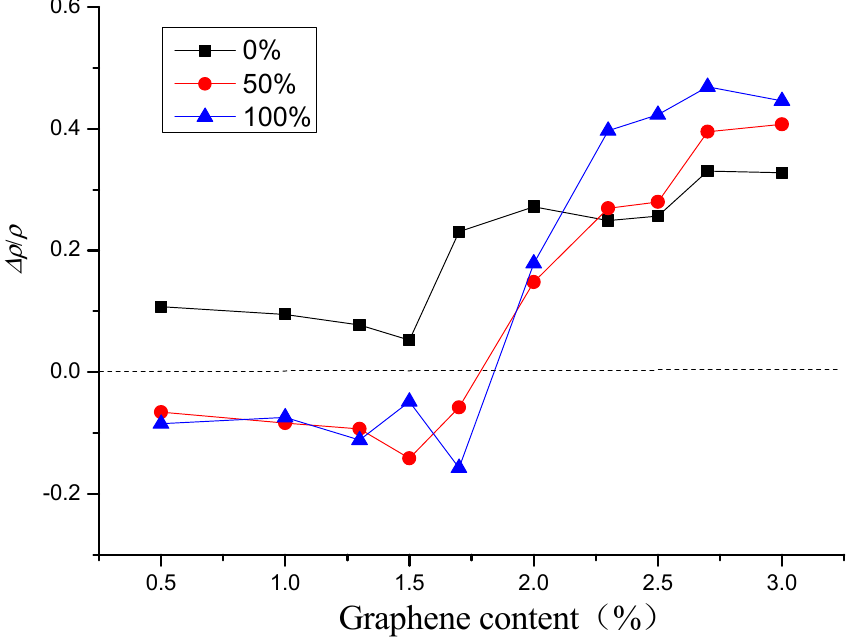
Figure 11. Relative change rates of electrical resistivity of specimens with different graphene content after freeze–thaw.